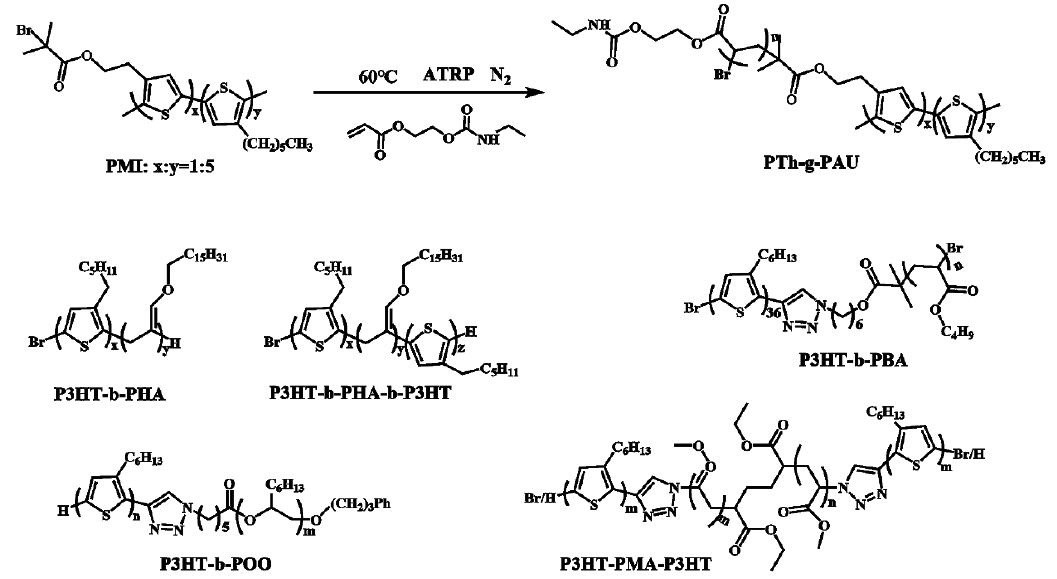
Figure 5. IEOSs obtained by free radical polymerization and click reaction.